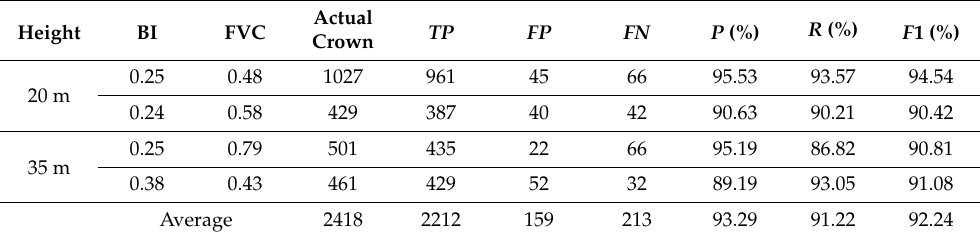
Table 5. Statistical table of crown recognition (color vector + LBP + GLCM).